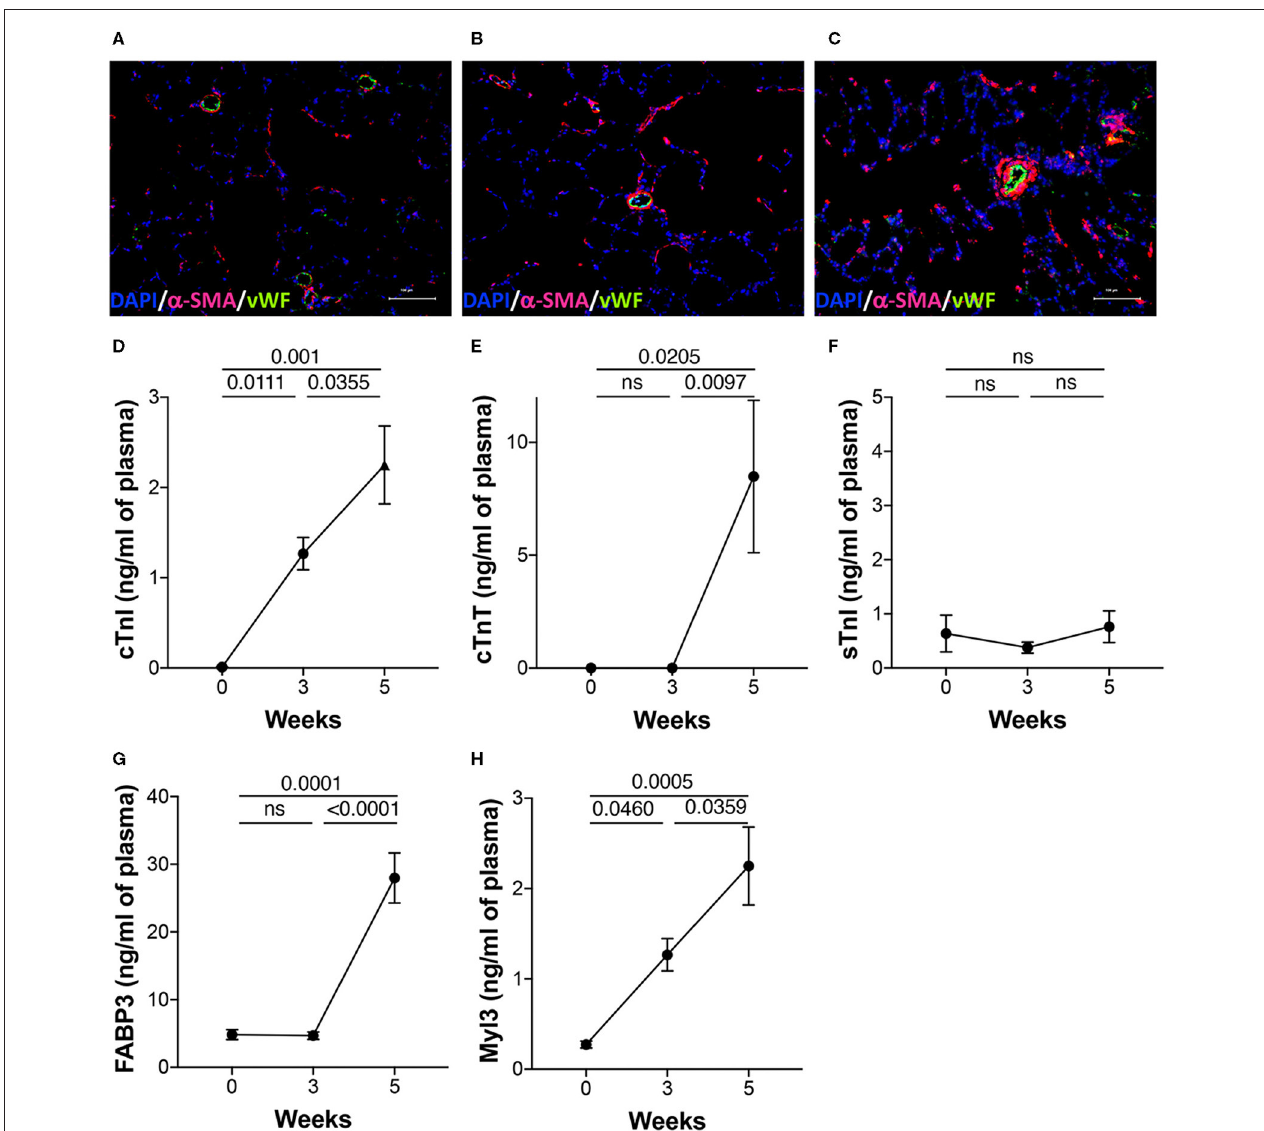
FIGURE 3 | Lung histology and plasma biomarkers of cardiac injury. PAH was induced in rats over a 5-week period as described in the Methods. (A–C) Representative images of the lung sections from the three time points stained for anti-vWF and anti- α SMA as described in details in the Methods. DAPI was used as a counterstain to visualize nuclei in tissue. Plasma was collected from separate sets of animals from naïve (0 day), 3 and 5 weeks post-induction of PAH. Markers of injury were estimated in the plasma using a multiplexed, meso scale discovery platform for (D) cardiac troponin I (cTnI), (E) cardiac troponin T (cTnT), (F) skeletal troponin I (sTnI), (G) fatty acid binding protein 3 (FABP3), and (H) myosin light chain 3 (Myl3). N = 5–9